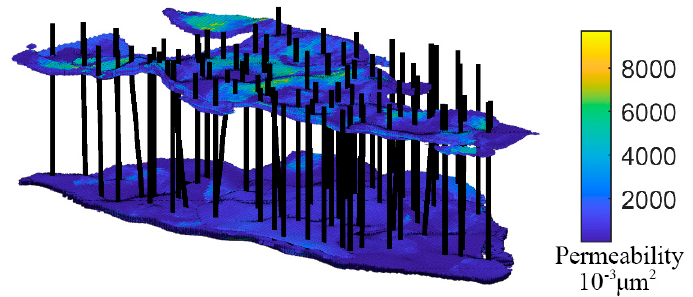
Figure 20. Permeability distribution of a typical continental heterogeneous reservoir.